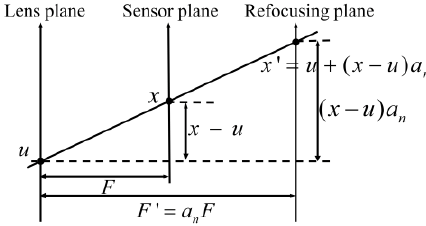
Fig. 1. Digital refocusing principle of light field